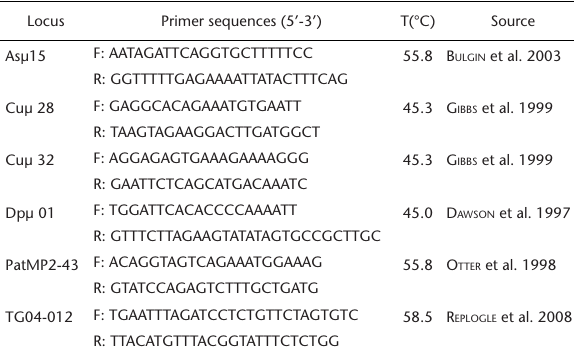
Table 1. Microsatellite loci used for paternity tests in Turdus albicollis , primer sequences, annealing temperature (T), and source.